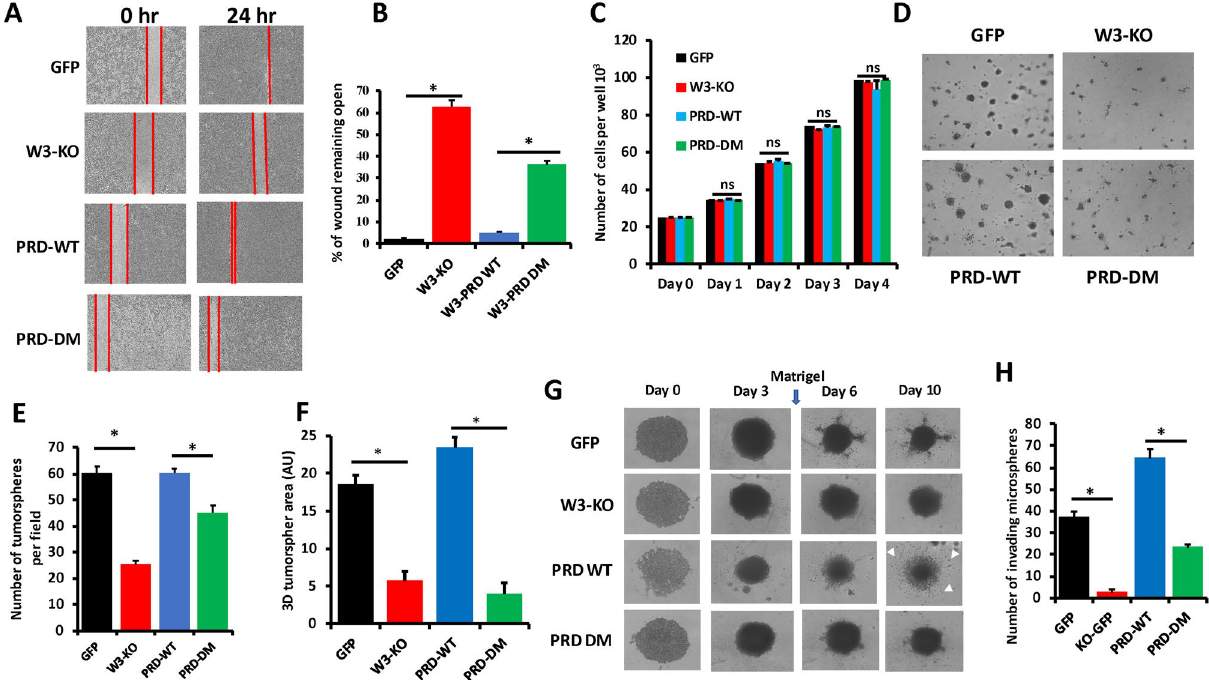
Figure 3. Phosphorylation of the WAVE3 PRD domain is required for migration and invasion of BC cells in vitro. ( A ) Representative micrographs of wound healing assays of confluent cell cultures of parental MDA-MB-231 cells (GFP), their WAVE3-deficient derivatives (W3-KO) or the W3-KO expressing either PRD domain wild-type (PRD-WT) or phospho-mutant (PRD-DM) WAVE3 that were induced to migrate into scratch wounds in confluent monolayers over 24 h. ( B ) Quantification of the unclosed wound (open area) at 24 h from 12 different wounds was measured and plotted as the percentage of the wound at time zero for MDA-MB-231 cells. ( C ) Cell proliferation over 5 days ( D ) Representative micrographs of parental MDA-MB-231 and its derivatives induced to form tumorspheres. ( E ) Quantification of the number of tumorspheres formed per area of the field. ( F ) Quantification of the total area occupied by resulting tumorspheres. ( G ) Representative micrographs of parental MDA-MB-231 and its derivatives induced to form tumorspheres. Single spheres were made in a 96-well ULA plates and Matrigel (2.5 v/v) was added to the tumorsphere cultures at day 3 and images were captured using Incucyte for 10 days. White arrows represent invading microspheres. (H) Quantification of the number of invading microspheres at day 10. Data are the means ± SD (n = 3, * and **, p < 0.05; Student’s activity of the full length WAVE3, and that tyrosine phosphorylation of WAVE3-PRD domain if required for the in vitro oncogenic activities of WAVE3 in BC cells in vitro. Phosphorylation of the WAVE3 PRD domain is required for the growth of BC primary tumors in vivo. To further assess the effects of loss of phosphorylation in the WAVE3-PRD domain on tumor growth and metastasis in vivo, mammary fat pads of NOD-scid-IL2Rgamma knockout (NSG) mice were inoculated with parental MDA-MB-231 cells (GFP), W3-KO, or W3-KO re-expressing either wild-type PRD domain (W3-WT- PRD) or phospho-mutant PRD domain (W3-PRD-DM), and tumor growth was assessed over 8 weeks. Loss of WAVE3 inhibited the growth of primary tumors (Fig. 4A,B). Re-expression PRD-WT, not only restored tumor growth, but enhanced tumor growth to levels that were significantly higher (p < 0.05) than those obtained with the parental group, while re-expression of PRD-DM resulted in tumor growth comparable to that obtained with the W3-KO group (Fig. 4A,B). Not every mouse in every group developed tumors (tumor incidence) ∼ 8 weeks post tumor cells implantation (Fig. 4C). While 90% and 100% of mice implanted with parental MDA-MB-231 and PRD-WT cells, respectively, developed tumors, only 70% and 60% of mice implanted with W3-deficient and PRD-DM cells, respectively, developed tumors (Fig. 4C). The reason for not achieving 100% tumor incidence in the control group may simply be linked to a technical failure during the injection process, since that same mouse was injected on both the right and left abdominal mammary glandes; the left side developed a large tumor, while the right side did not. Tumor latency was also affected as a result of loss of WAVE3 or re-expression of PRD- DM; tumors in these mice were palpable 30 and 35 days post implantation, while in the mice implanted with the parental cells or the PRD-WT cells tumor latency was reduced to 21 days post implantation (Fig. 4C). Tumor burden, as assessed by tumor volume (Fig. 4A) and weight (Fig. 4B), was significantly lower (p < 0.05) in the mice implanted with the WAVE3-deficient cells and the WAVE3-deficient re-expressing phospho-mutant PRD. Thus, loss of phosphorylation the WAVE3 PRD domain inhibits the rate of primary tumor growth in vivo. These differences in tumor burden were not a result of changes in tumor cell proliferation by manipulation of WAVE3